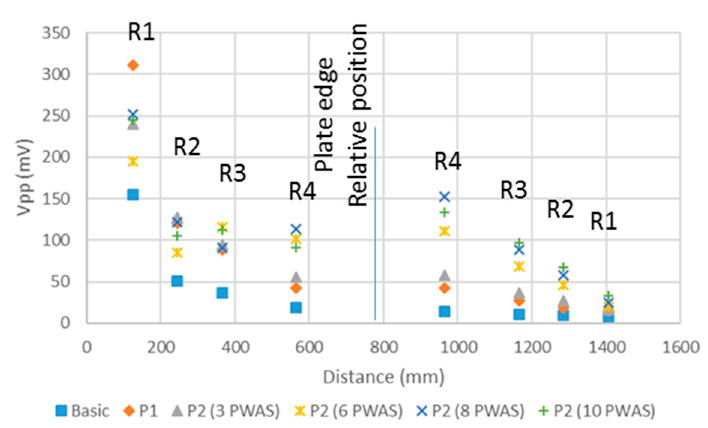
Figure 9. Peak-to-peak voltage of the waves acquired in each PWAS along the direct propagation path and the path of the wave reflected in the plate edge (according to the different UGWT procedures tested).